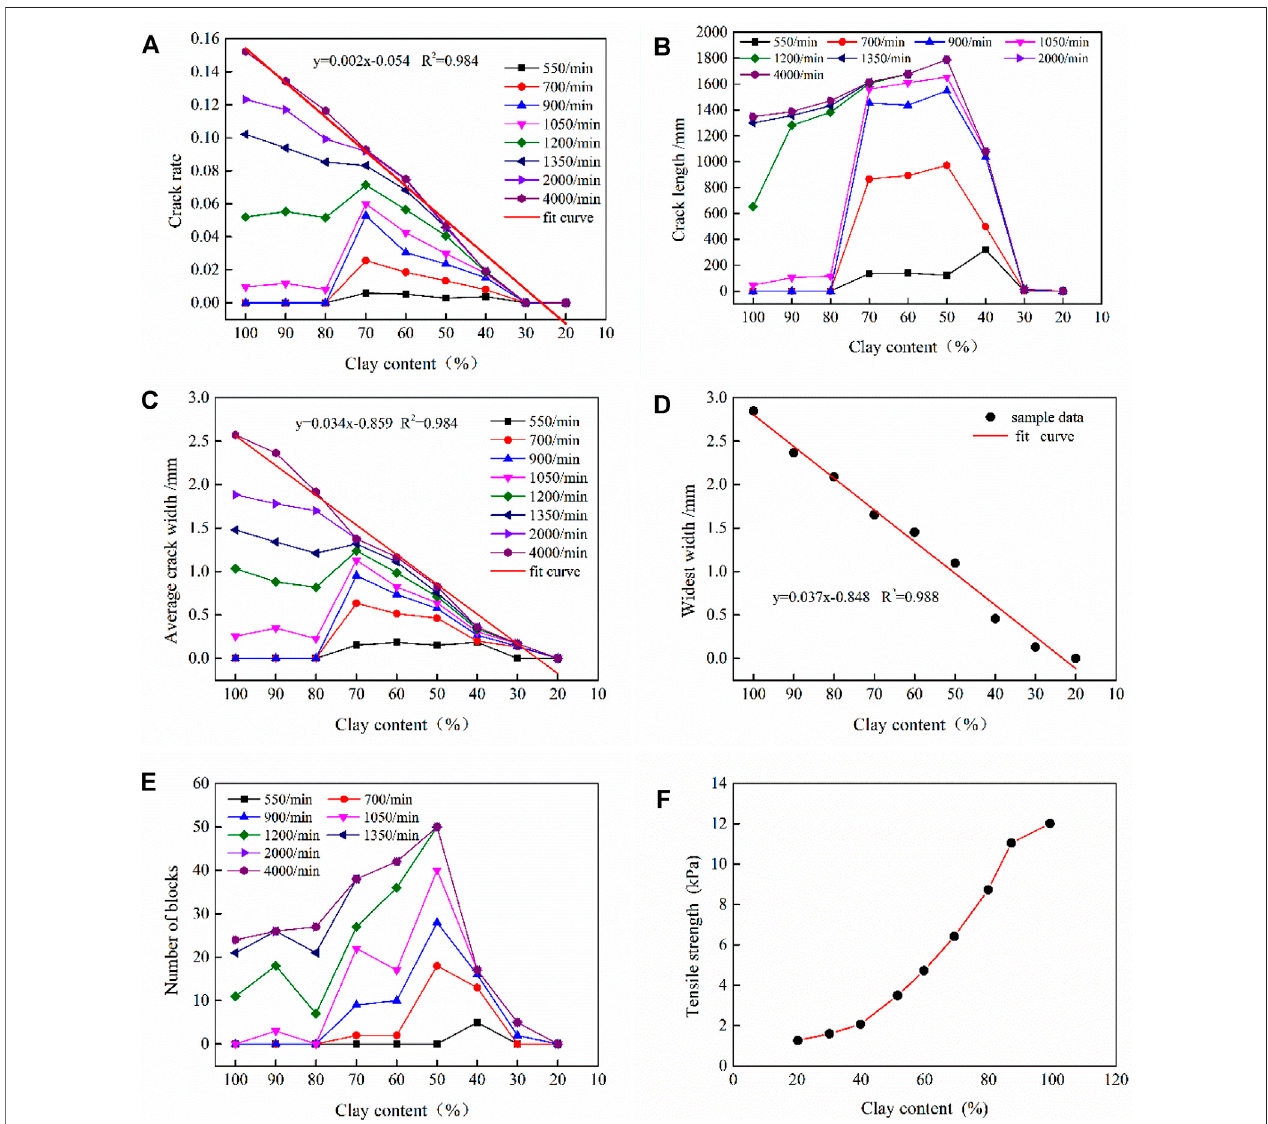
FIGURE 6 | Relationship between the crack parameter and tensile strength and clay content: (A) relationship between the crack rate and clay content. (B) Relationship between the crack length and clay content. (C) Relationship between the average crack width and clay content. (D) Relationship between the maximum crack width and clay content. (E) Relationship between the number of blocks and clay content. (F) Relationship between the tensile strength and clay content.